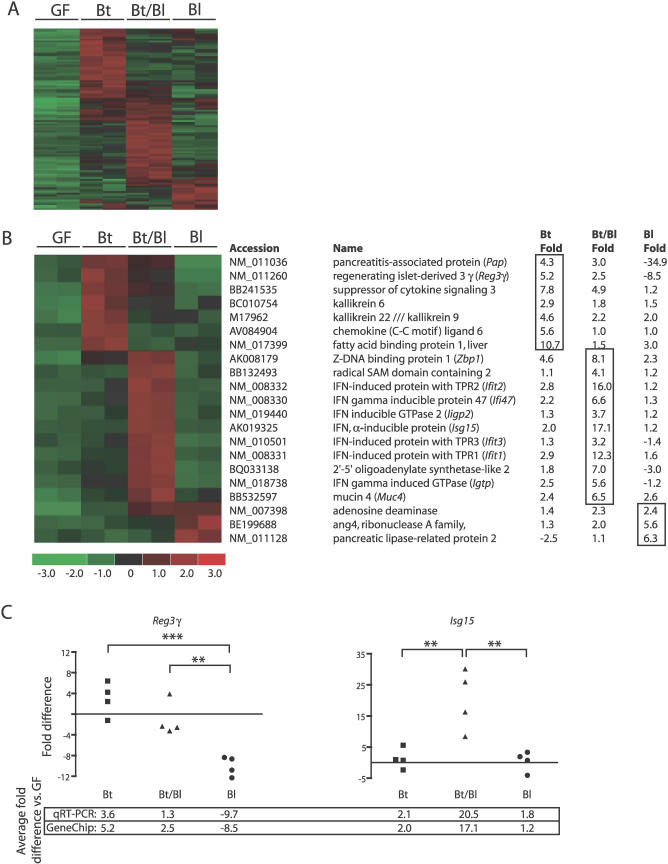
Gene Expression Changes in the Cecal Epithelium Induced by Colonization(A) Cluster diagram from GeneChip studies of laser capture microdissected mouse cecal epithelium illustrates genes that meet the four criteria described in Materials and Methods including a 2-fold or greater increase in expression (using the 90% confidence bound of fold-change) in B. thetaiotaomicron mono-associated (Bt), B. longum mono-associated (Bl), or co-colonized ceca (Bt/Bl) compared with germ-free (GF) controls.(B) Genes involved in immuno-inflammatory responses that are up-regulated in at least one colonization state; fold-increase in expression in each colonization state is relative to the germ-free state. The expression pattern for Pap (Pancreatitis associated protein, a member of the C-type family of lectins known to bind terminal glycan structures in fungi and bacteria), and several other genes was confirmed using an independent GeneChip platform that queries a subset of genes in the mouse genome relevant to carbohydrate metabolism (Glyco-GeneChips; see Figure S9).(C) Real-time quantitative PCR assays of laser-captured microdissected cecal epithelial RNA isolated from individual animals colonized with B. thetaiotaomicron (Bt), B. longum (Bl), or co-colonized with both organisms (Bt/Bl) (n = 4 mice/group), using primers specific for Reg3γ or Isg15. Fold-changes are expressed relative to a reference RNA created by pooling equivalent masses of laser-captured microdissected cecal epithelial RNA from four germ-free animals. Average fold-changes for each group are indicated at the bottom, together with fold-changes derived from the GeneChip analysis. Significant differences in expression between groups for each gene were identified using a one-way ANOVA and Tukey post test; double asterisks (**) indicate p < 0.01, and triple asterisks (***) indicate p < 0.001.